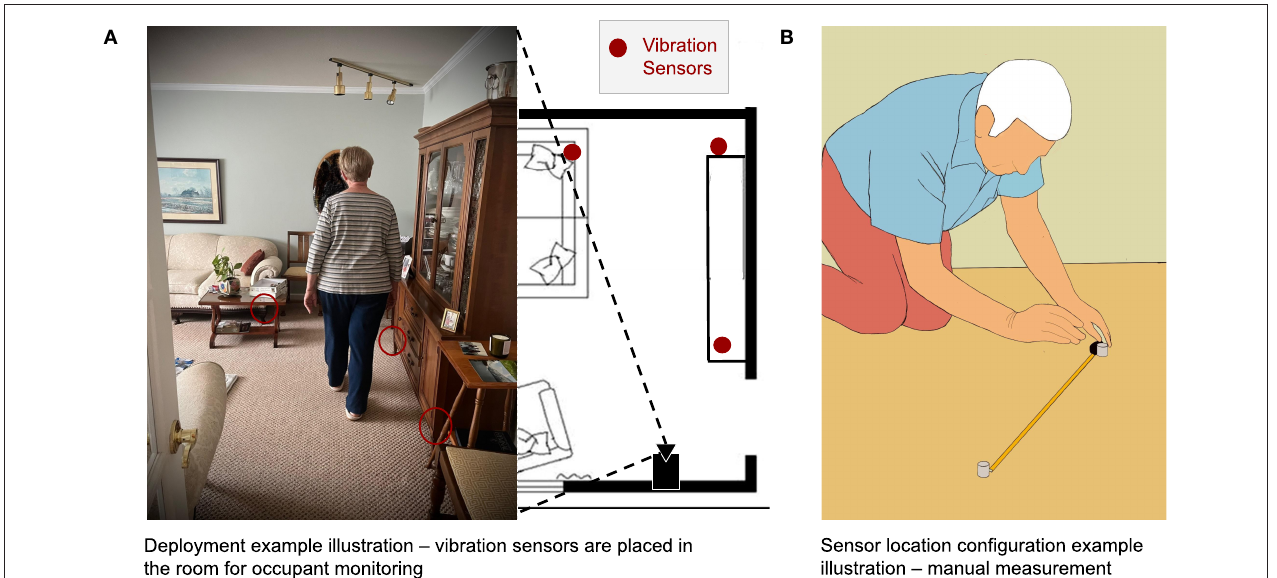
FIGURE 1 | Motivation examples for AutoLoc . (A) Vibration sensors are deployed in the living room area for application of elderly in-home monitoring. A co-located camera can capture the room view. AutoLoc estimates these vibration sensors’ location in the room coordinates via camera data with or without a line-of-sight to the vibration sensors. (B) Manual measurement of these vibration sensor locations is costly and could significantly impact the usability of the